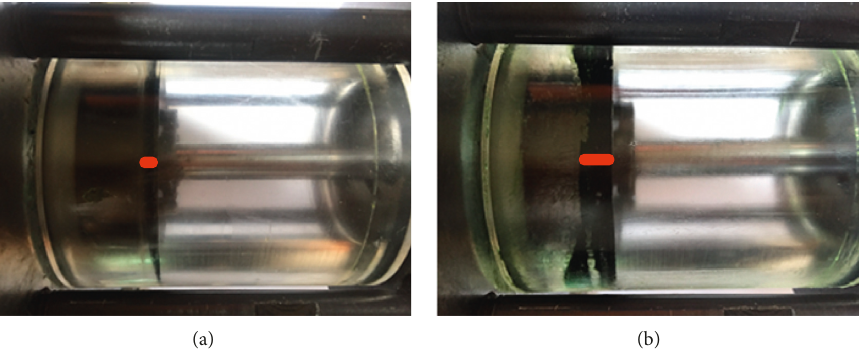
Figure 14: Surface contact of pistons: (a) standard piston; (b) bionic piston. The length of the red line is the contact width.